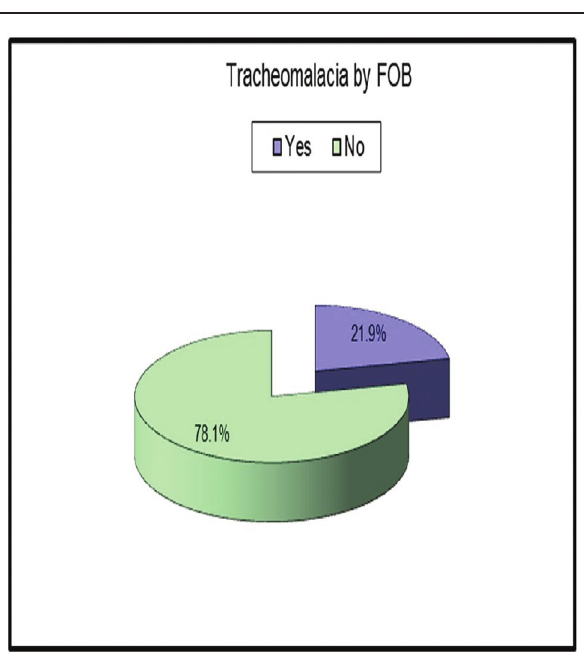
Table 11 Comparison between tracheomalacia by ultrasound and fiberoptic bronchoscopy Percentage of collapsibility by US Tracheomalacia by FOB